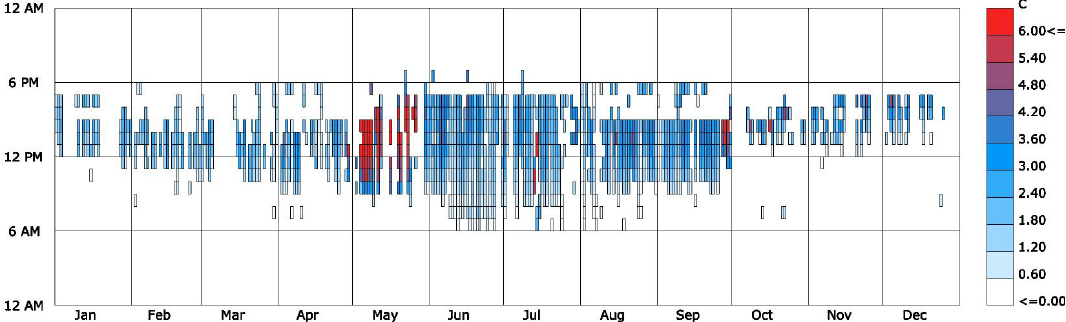
Figure 6. Hourly underside surface temperature differences of UST-Green vs. UST-Black.